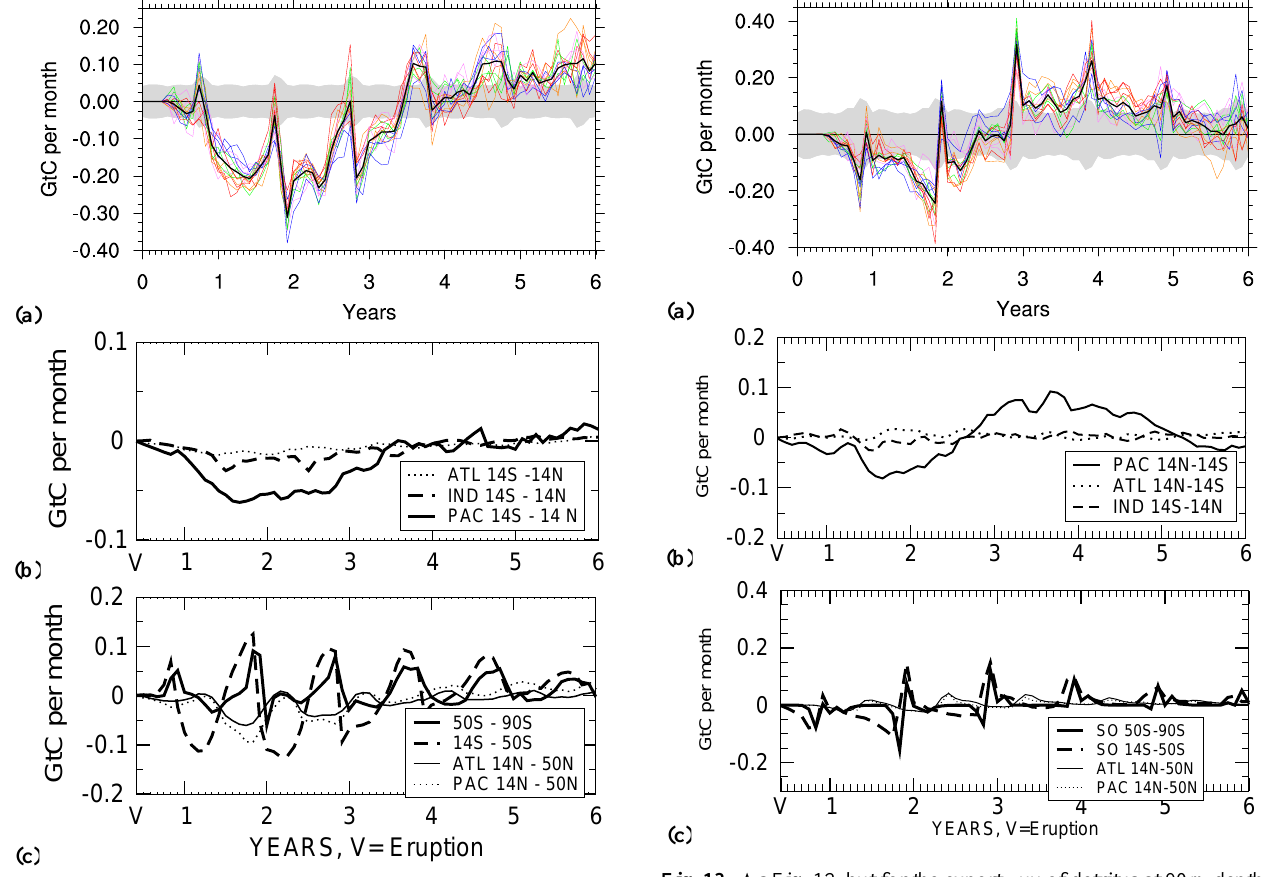
Fig. 12. Time series of monthly mean carbon flux anomalies from ocean to atmosphere in GtC per month for the first six years of the experiment. (a) globally averaged ensemble mean (black line) and individual members (coloured lines and grey shaded area as in Fig. 2), (b) ensemble mean averaged between 14 ◦ S and 14 ◦ N in the Atlantic (dotted), the Indian Ocean (dash-dotted) and the Pa- cific (solid). (c) ensemble mean for the Southern Ocean between 50 ◦ S and 90 ◦ S (bold), for all ocean basins between 14 ◦ S and 50 ◦ S (dash-dotted), and between 14 ◦ N and 50 ◦ N for the Atlantic (thin) and the Pacifc (dotted).